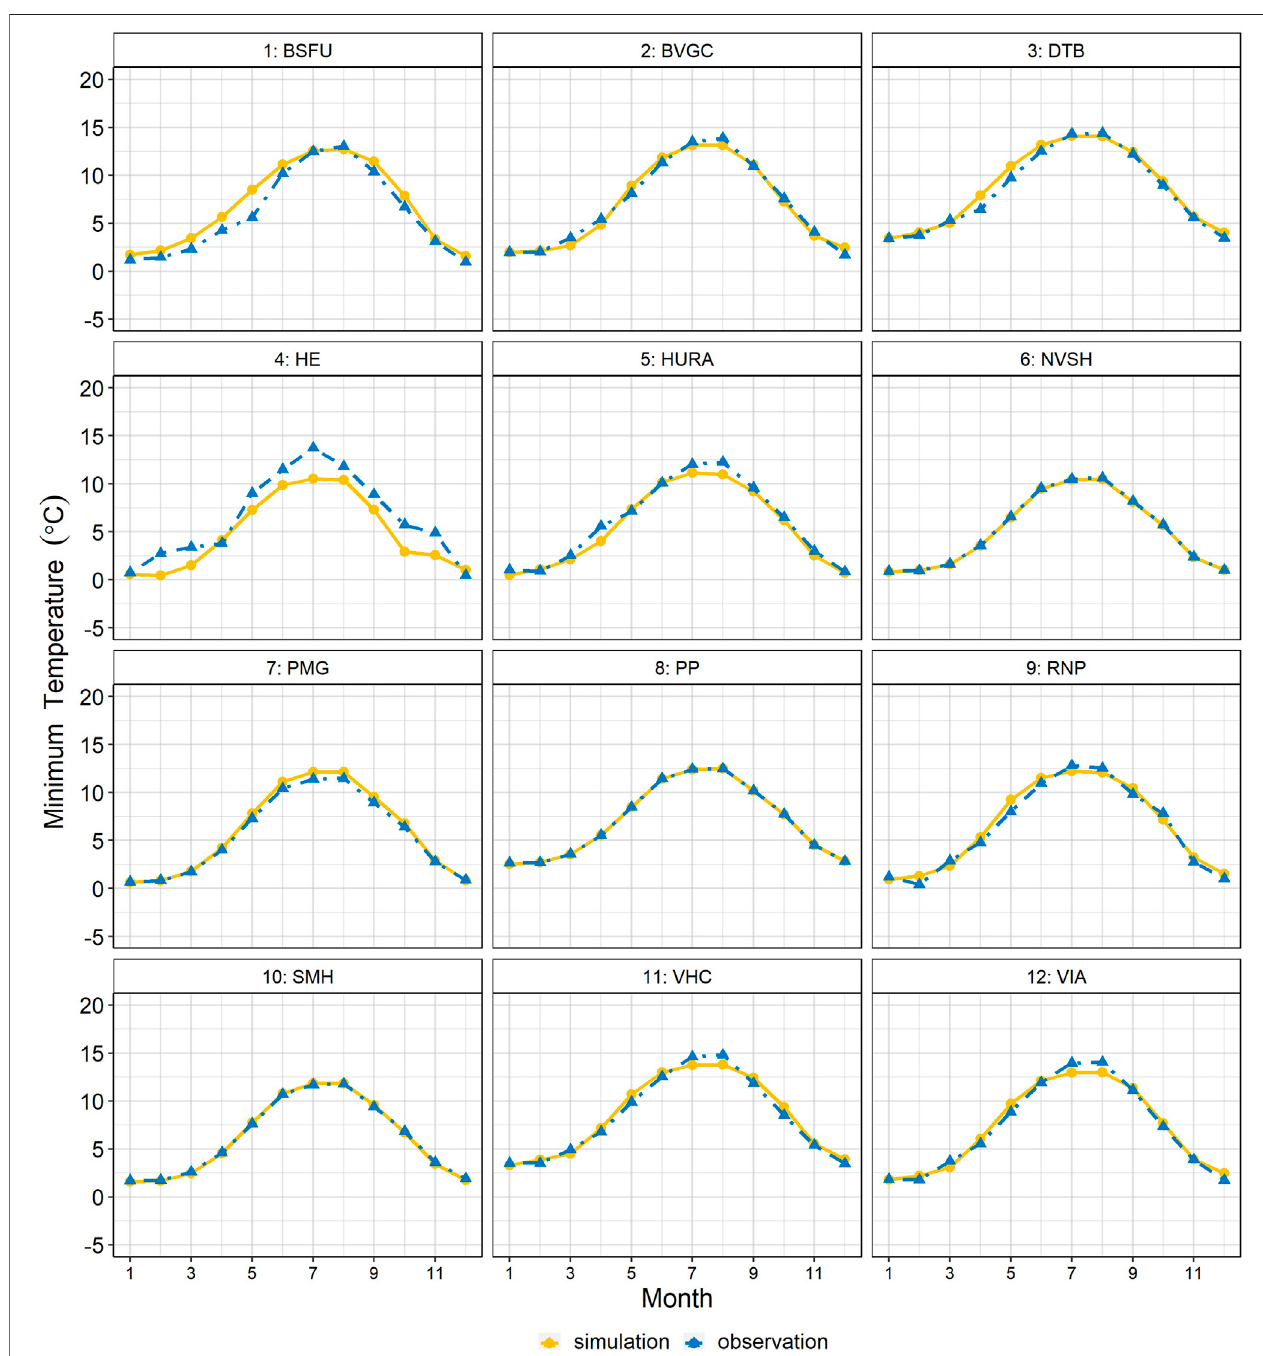
FIGURE 4 | Monthly comparisons between minimum temperature simulation and